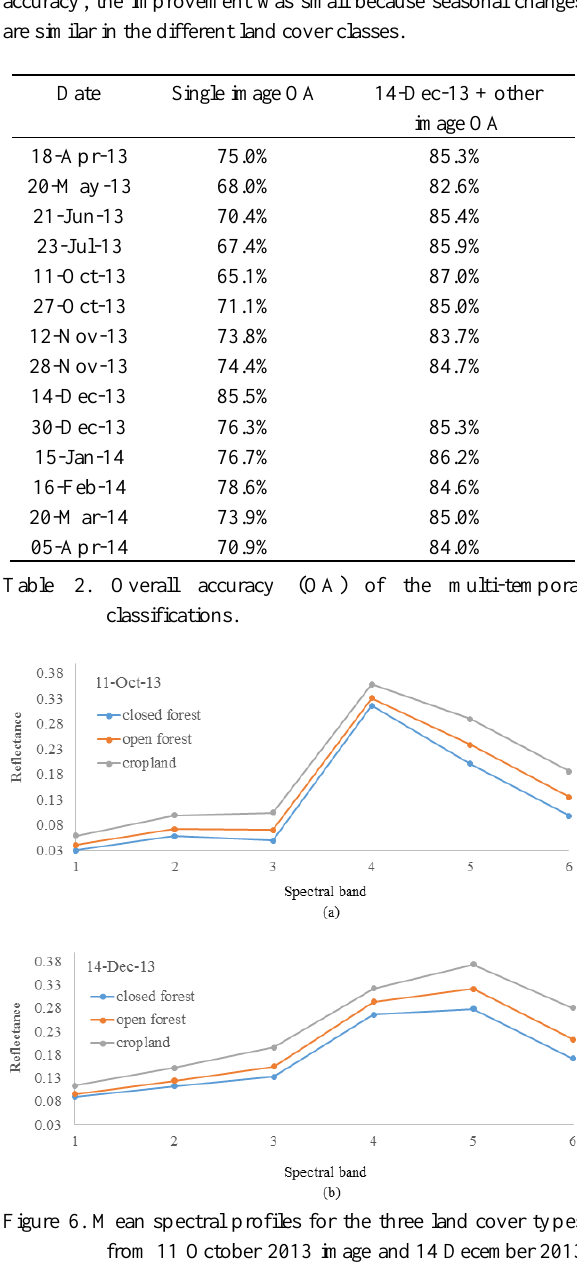
Figure 6. Mean spectral profiles for the three land cover types from 11 October 2013 image and 14 December 2013 image